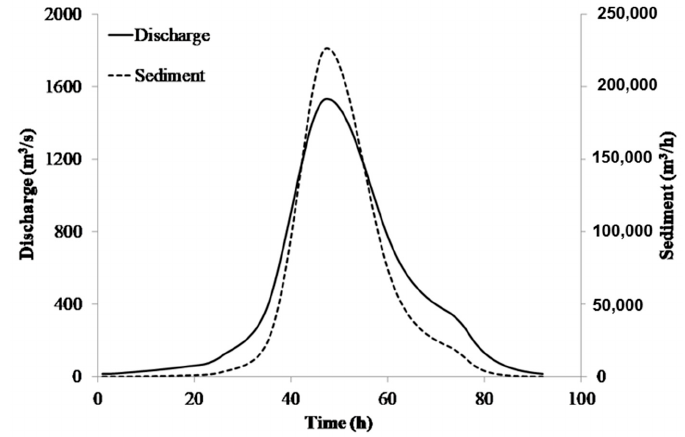
Table 2. Scale ratio of the prototype and the model.